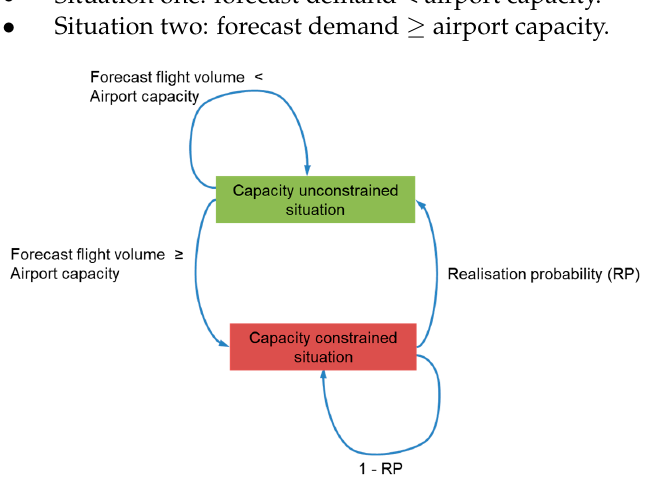
Figure 6. Markov chain of runway expansion.